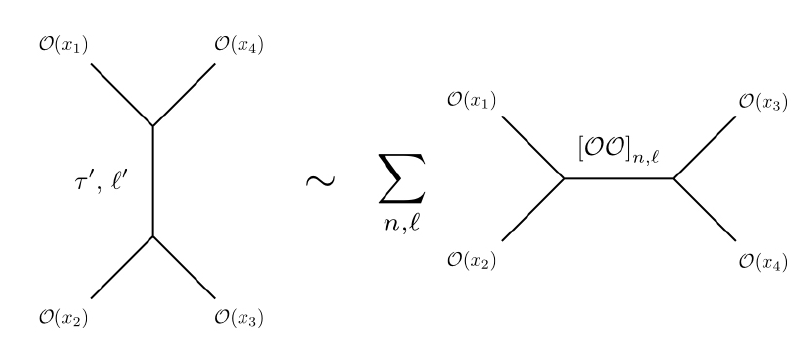
Figure 1 . s -channel decomposition of the exchange of an operator of twist (cid:28) 0 and spin ‘ 0 (+de- scendents) in the crossed